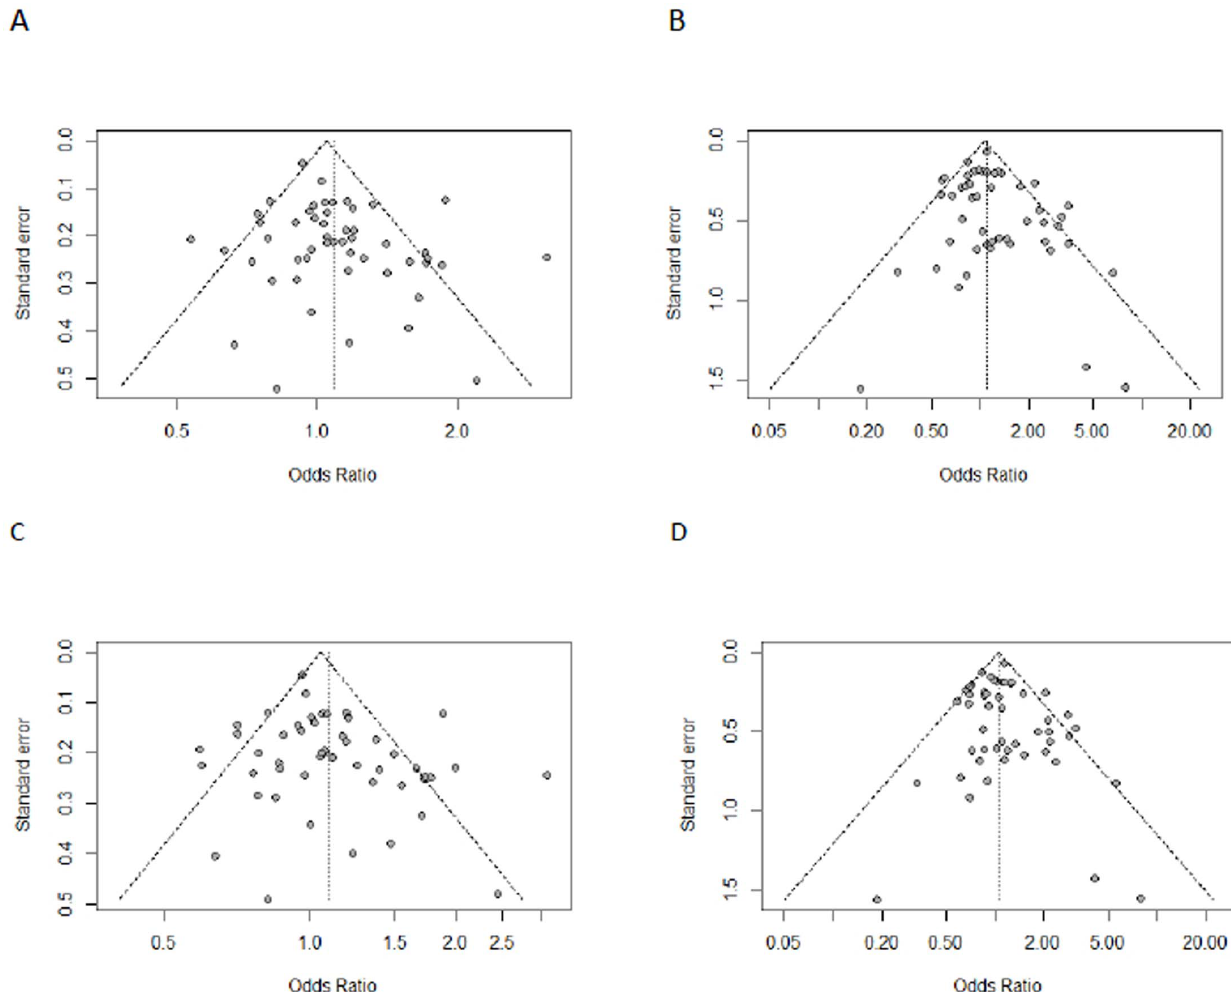
Figure 5. Begg’s funnel plot of the Egger’s test for publication bias of SULT1A1 Arg213His polymorphism and cancer risk. (A) heterozygous model (B) homozygous model (C) dominant model (D) recessive model The horizontal line in the funnel plot indicates the fixed-effects summary estimate, whereas the sloping lines indicate the expected 95% confidence intervals for a given SE.